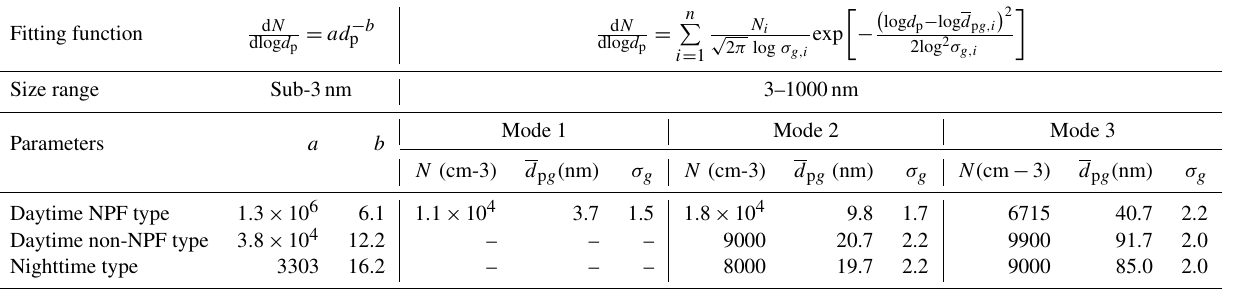
Fitting function